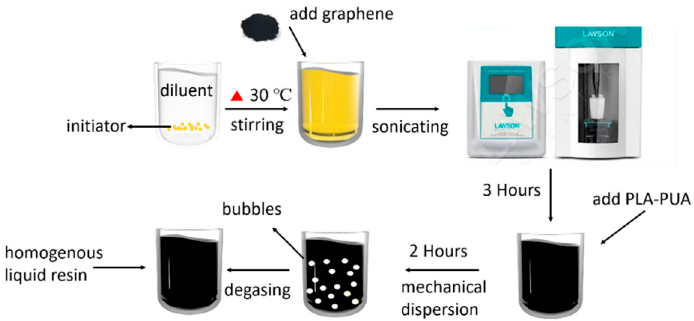
Figure 1. Schematic procedures of the preparation process for graphene-reinforced nanocomposite.